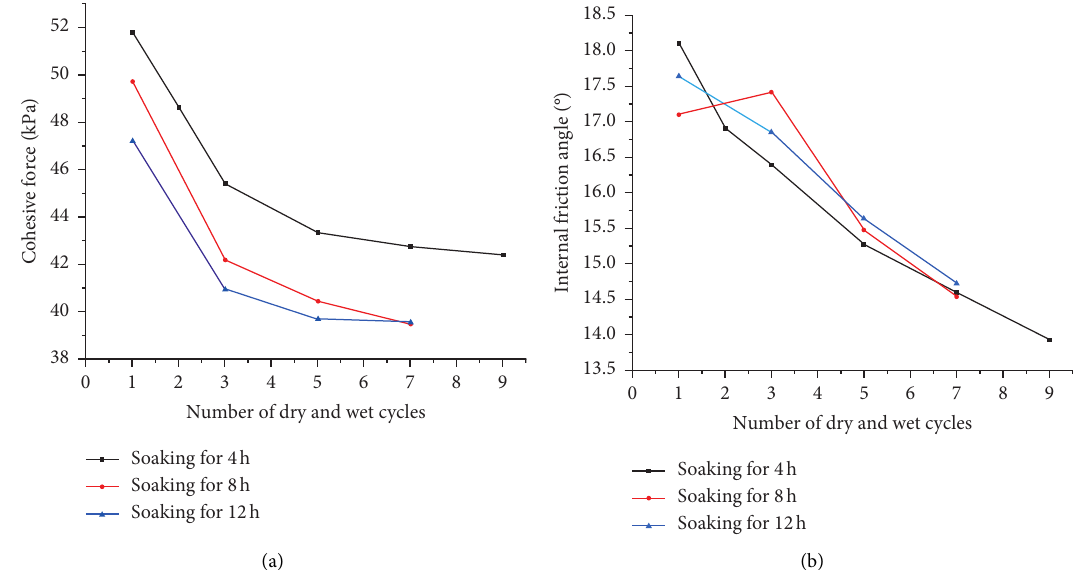
Figure 11: Relationship between c and φ parameters and different dry and wet cycles (4 h, 8h, and